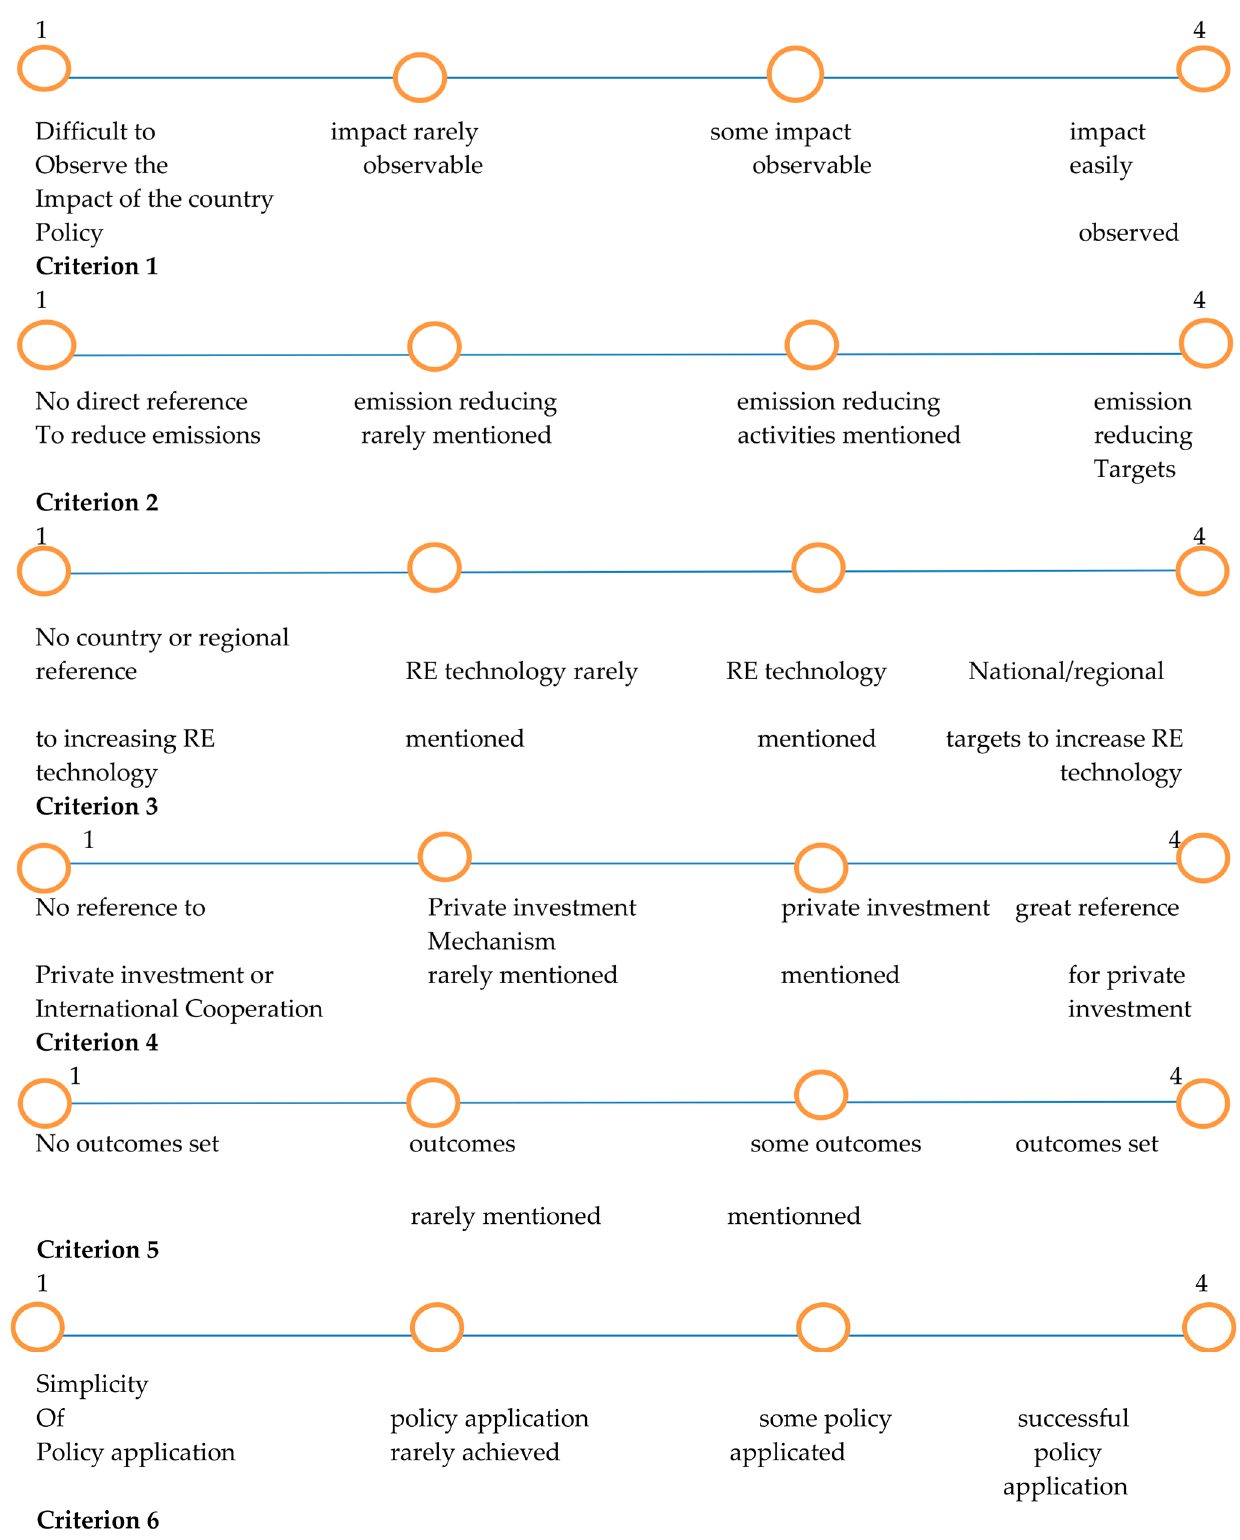
Figure 3. Scoring scale .